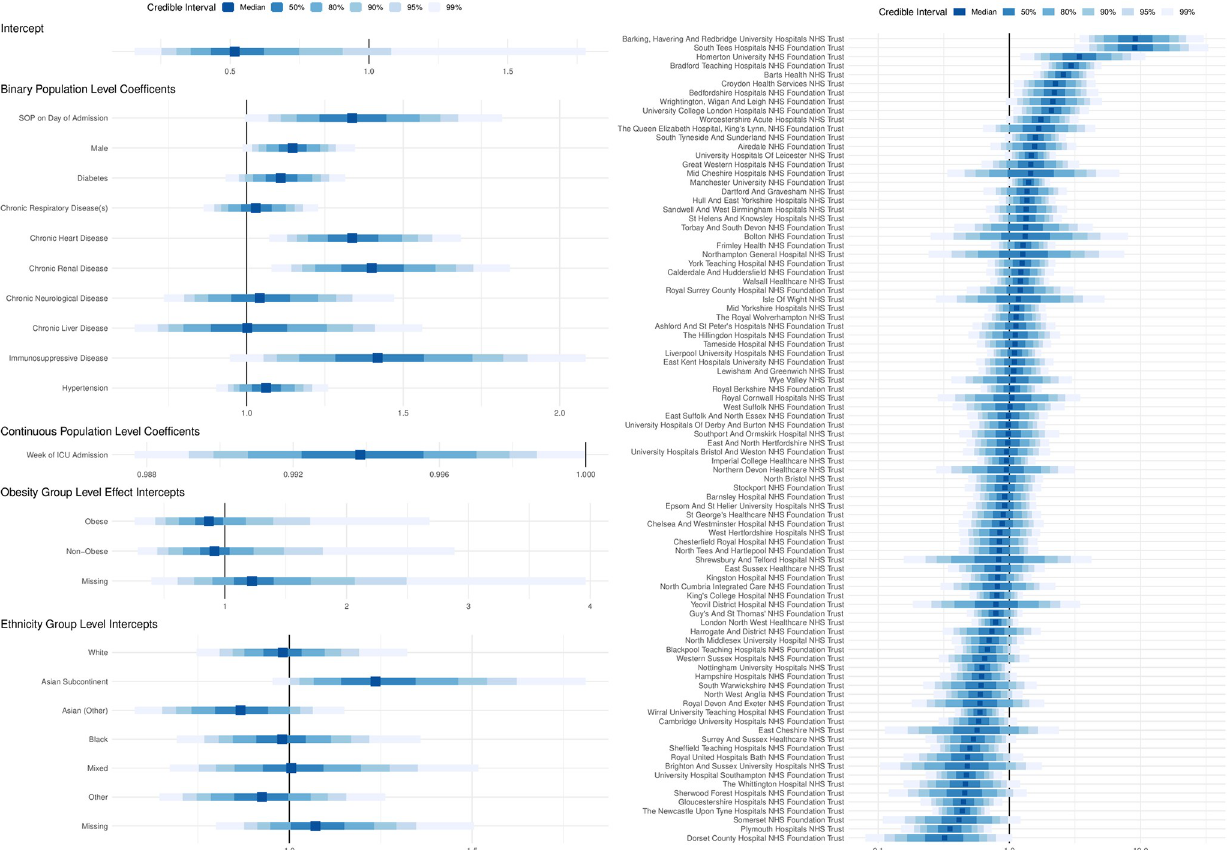
Fig 3. Forest plot of all co-variates in the final model where a binary flag indicating that a serious operational problem occurred on the date of admission. (Left) A forest plot of all the effect estimates and marginal posterior densities for each covariate in the final model in which a serious operational problem occurred on the date of admission was captured using a binary flag (Yes/No). (Right) The marginal posterior densities (on a log odds scale) for the random effect for each trust (i.e. small group of hospitals that function as a single operational unit), in the aforementioned